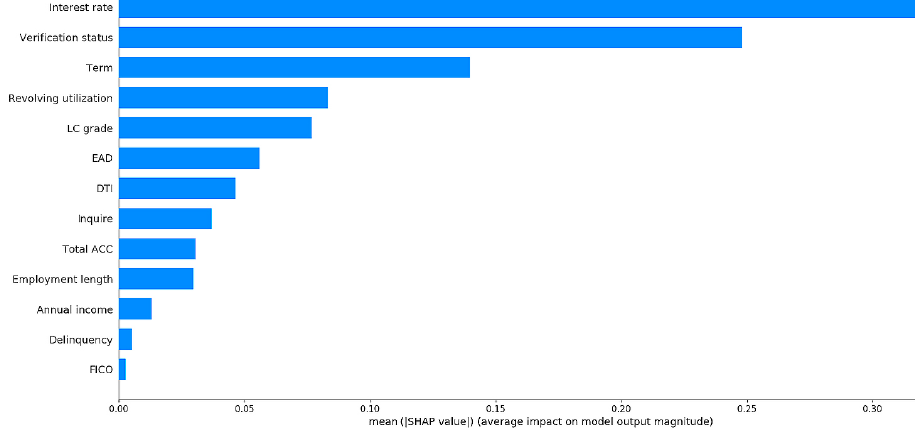
Figure 4. 5-fold cross-validation SHAP feature importance of XGBoost under Lending club dataset. The SHAP feature importance is measured by average absolute Shapley values and visualized in descending order